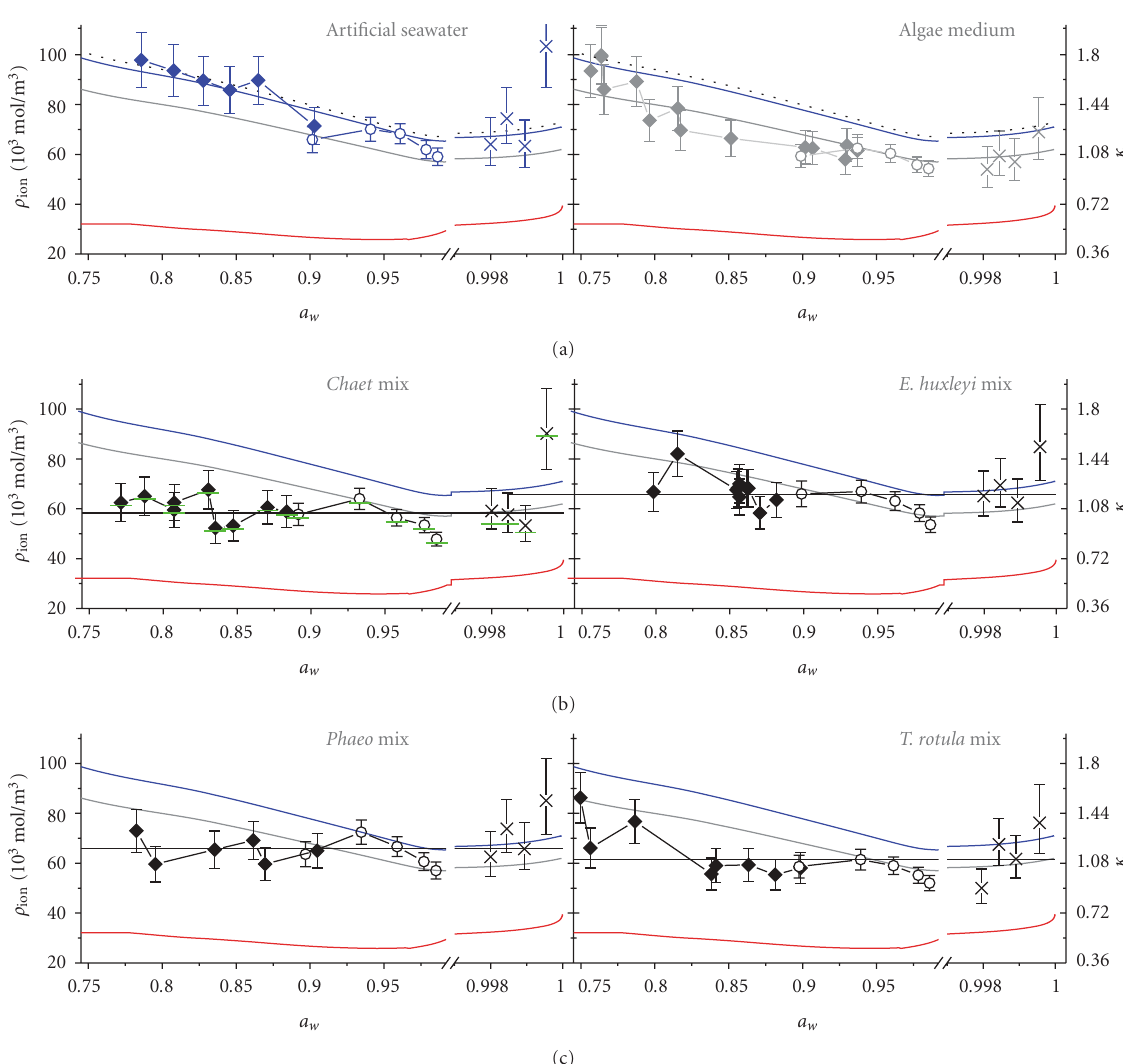
Figure 4: ρ ion derived from measured hygroscopic growth and activation; filled and open symbols were derived from H-TDMA and LACIS measurements, respectively, crosses from CCNc measurements (respective κ values are indicated at the right axis). Additional curves are thought as guide for the eye. More details about them are given in the